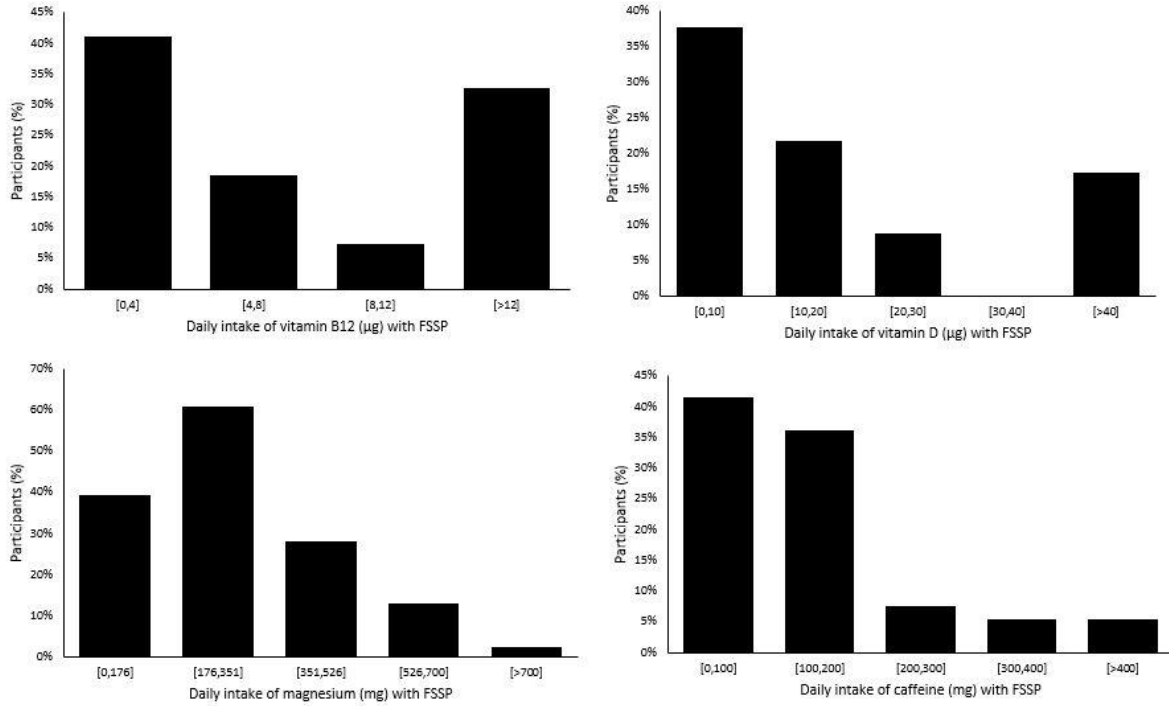
Figure 3. Daily intake of specific ingredients of food supplements and similar products (FSSPs) among study participants recruited from the Slovenian Armed Forces.